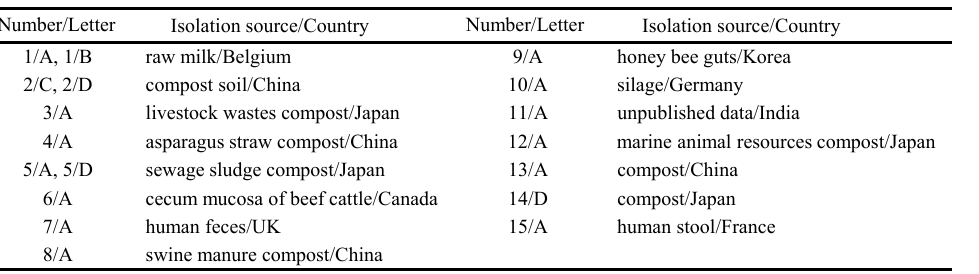
Figure 2. Phylogenetic tree comprising Bacillus sp. TAT105 and its closest relatives based on 16S rDNA sequence data. The scale bar indicates 0.01 substitution per nucleotide position. Accession numbers of the sequences in INSDC are shown in parentheses. The strains within the bracket on the right-side show 99% sequence identity with TAT105 16S rDNA. Superscript numbers and letters following the parentheses indicate the iso- lation sources and the countries where the strains and clones were isolated (1-15) and the types of restriction map of HaeIII and HinfI in 16S rDNA (A-D), respectively. The strains and clones with the same number were isolated by the same research group. The quick table below the phy- logenetic tree indicates correspondence between the numbers/letters and isolation sources/countries. Roman numerals I–III indicate the two clusters (I and III) and a strain (II) distinguished with these types: I with A or B, II with C, and III with D. The frames to the left of I and III indicate the ranges of their respective